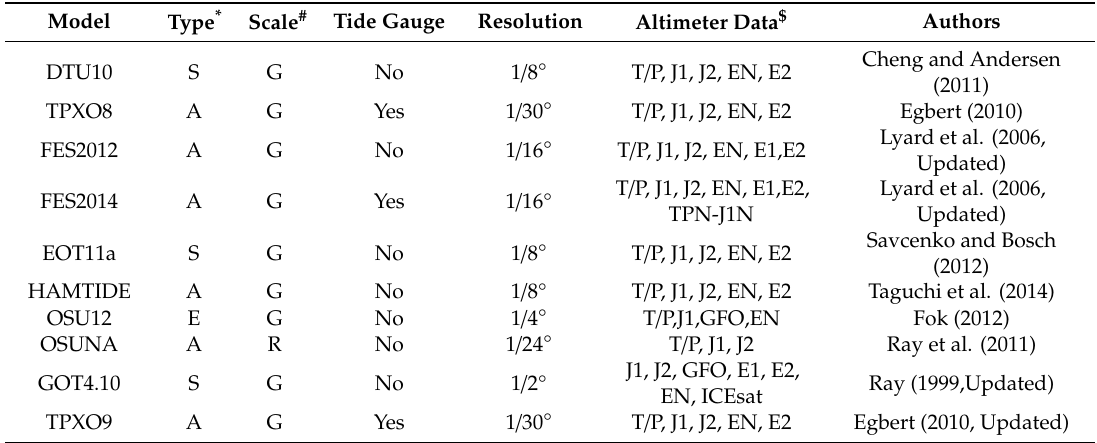
Table 2. The tidal models used in this